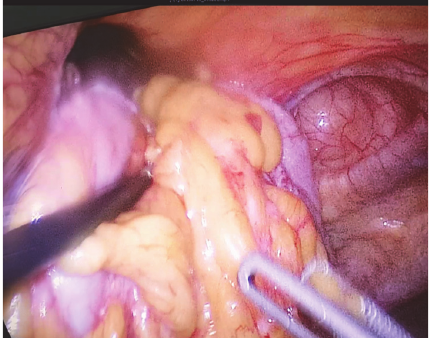
Figure 1: Thoracic CT scan. Stomach filled by contrast in right hemithorax.